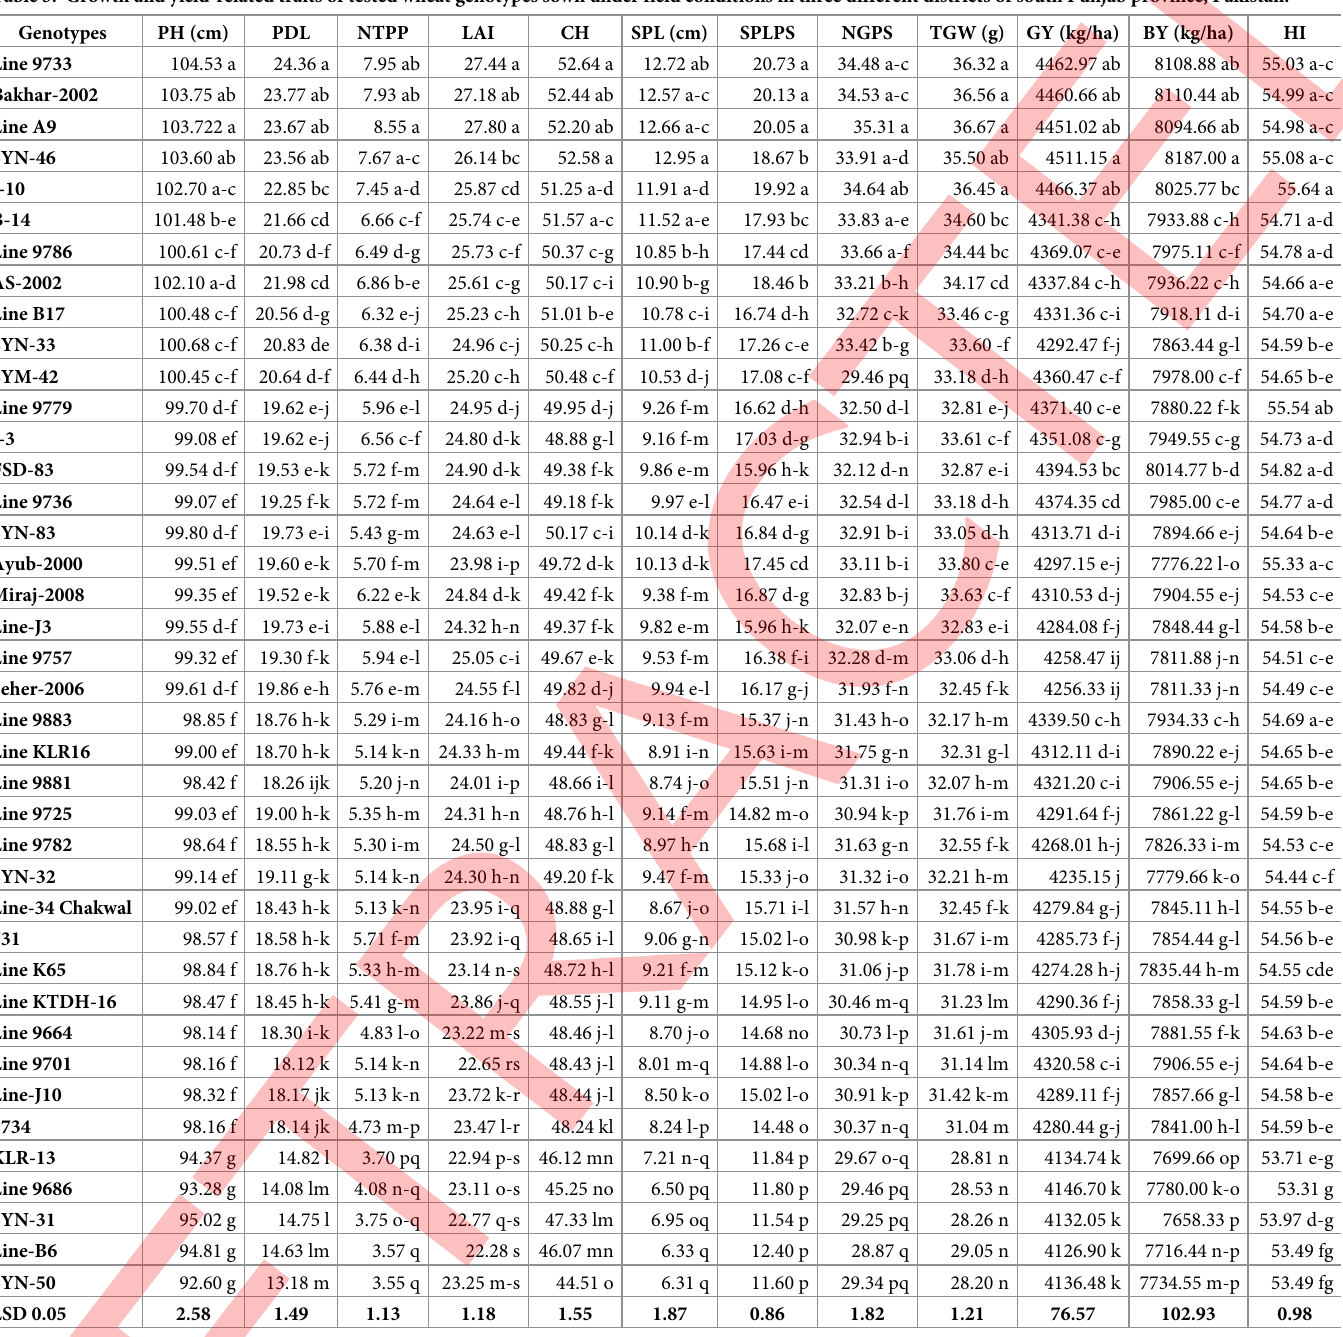
Table 3. Growth and yield-related traits of tested wheat genotypes sown under field conditions in three different districts of south Punjab province, Pakistan.